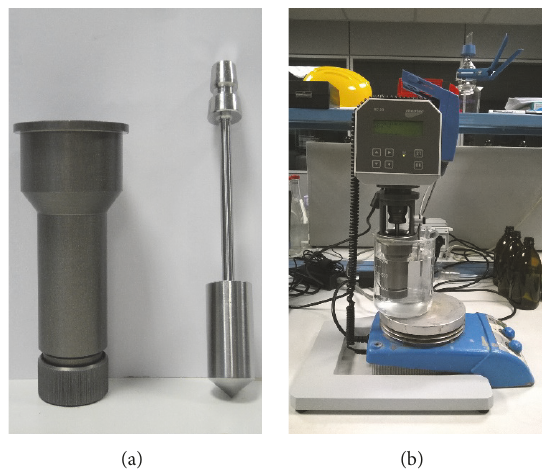
Figure 2: Experimental apparatus: coaxial cylinder CC25DIN (a) and rheometer RC20